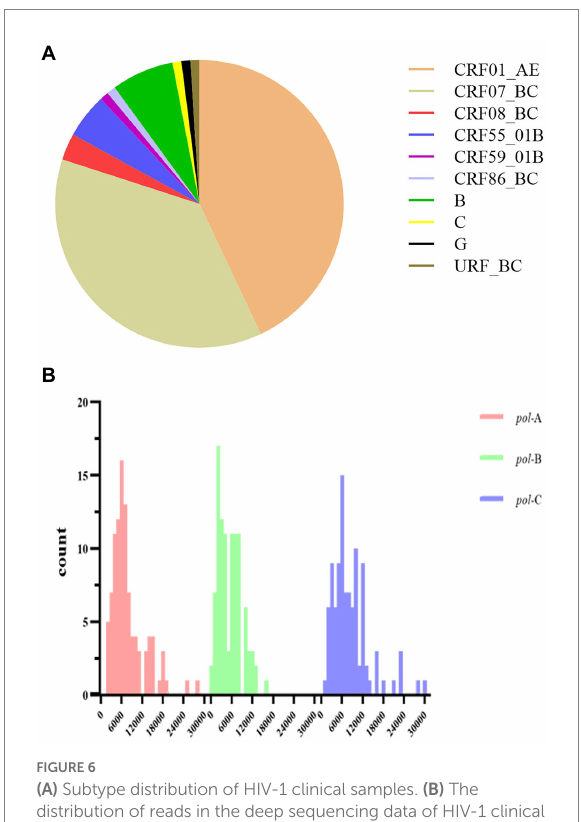
FIGURE 6 (A) Subtype distribution of HIV-1 clinical samples. (B) The distribution of reads in the deep sequencing data of HIV-1 clinical samples. After sequence quality control, the poor-quality sequences were filtered. Different colors represented the distribution of reads in the three segments in the pol gene region. The reads of pol -A, pol -B, and pol -C were respectively concentrated in 6,000 (range:1,694–28,069), 2,000 (range:389–16,008), and 6,000